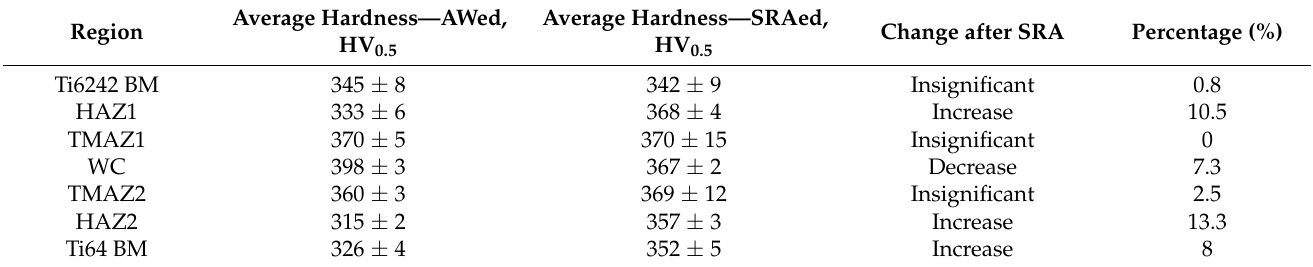
Table 2. Comparison of the average hardness in the different regions of the dissimilar Ti6242–Ti64 weld in the AWed and SRAed